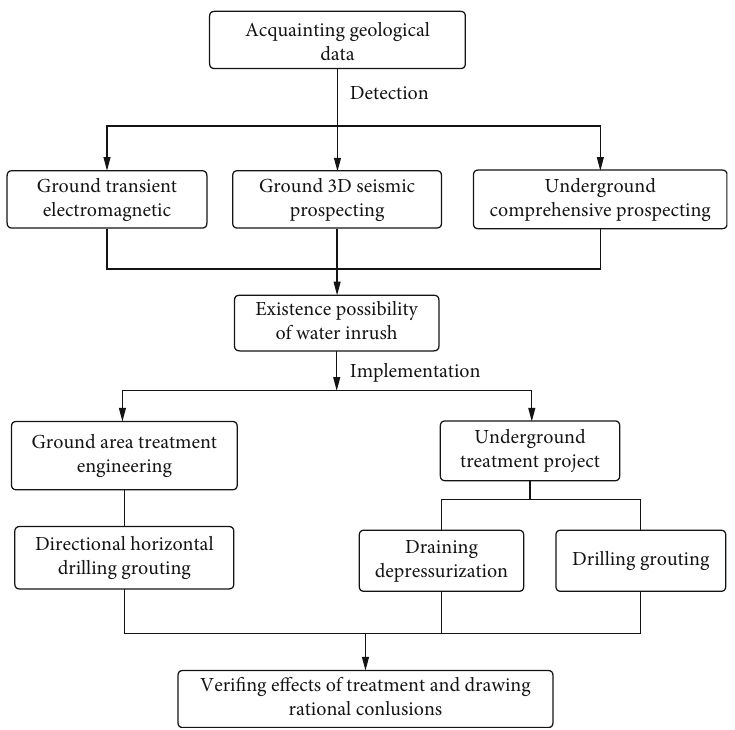
Figure 2: Flow chart of water inrush hazard prevention and